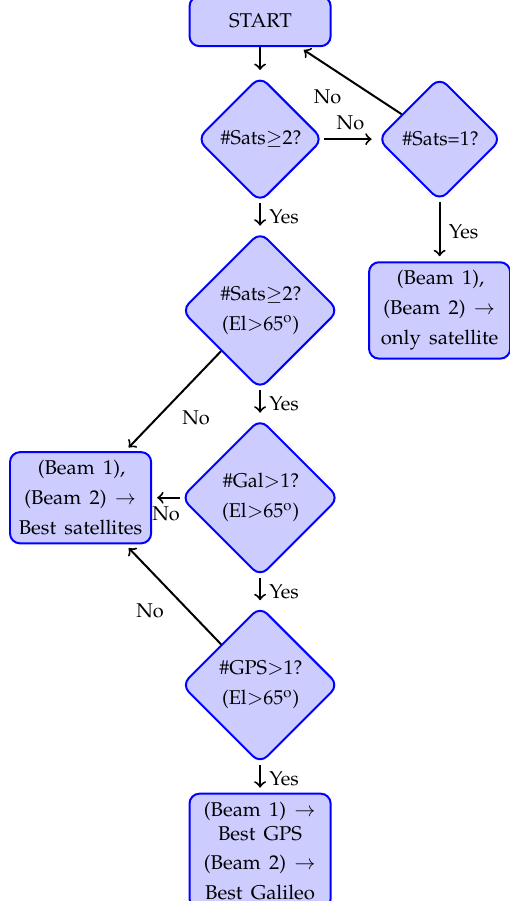
Figure 9. Developed selection algorithm to choose the best satellites available